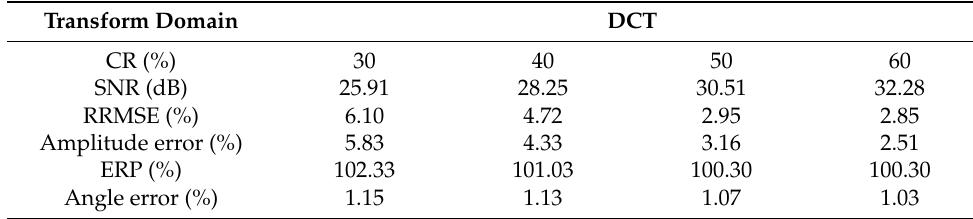
Table 8. Reconstruction results of the harmonic signal in the DCT domain.